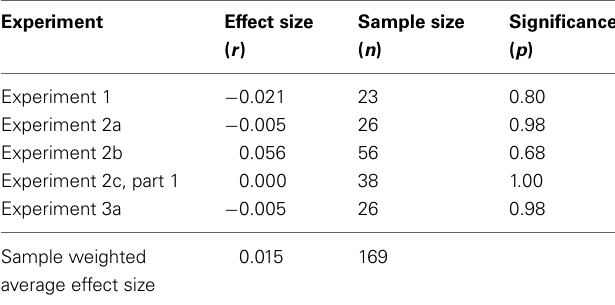
Table 6 | Meta-analysis: Effect of mind-blanking on behavioral outcomes (reading comprehension).